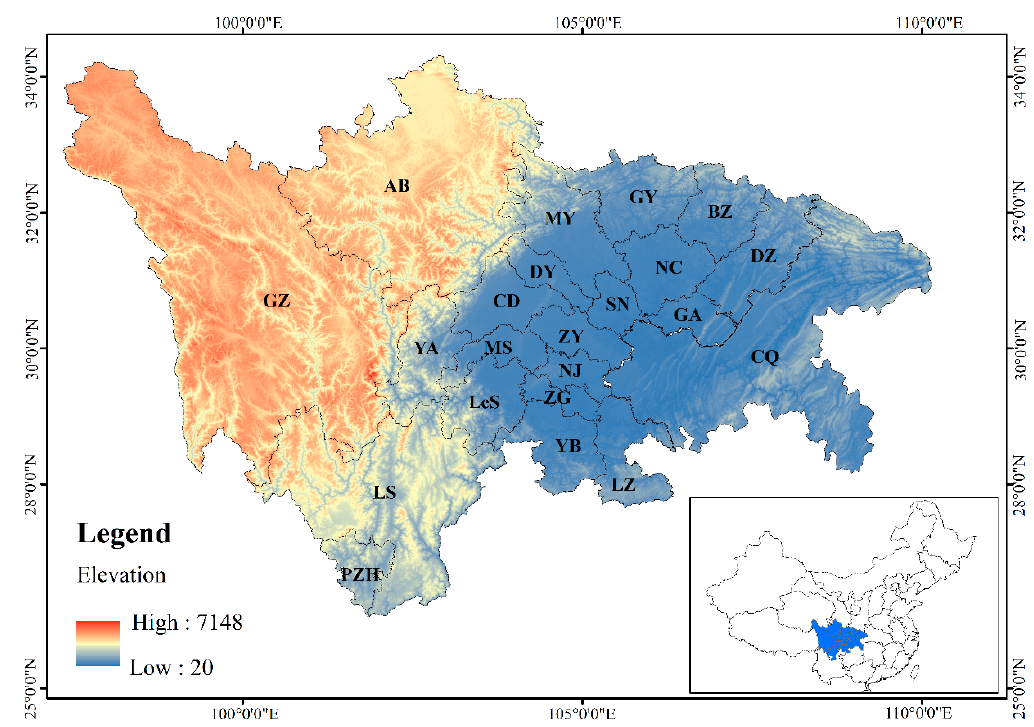
Table 1 listed the city’s abbreviations, number of vehicles, population, and GDP (Gross Domestic Product). In 2018, Chongqing’s total population was 31.01 million, the total number of vehicles was 6.31 million, and the GDP was 20363 billion yuan, ranking first among the cities. As another megacity in Sichuan Basin, Chengdu has a total population of 16.33 million, a total of 4.87 million vehicles, and a GDP of 1.5342 billion yuan, second only to Chongqing. Table 1. Urban areas, population, number of vehicles, and GDP of each city in the Sichuan Basin in 2018. City